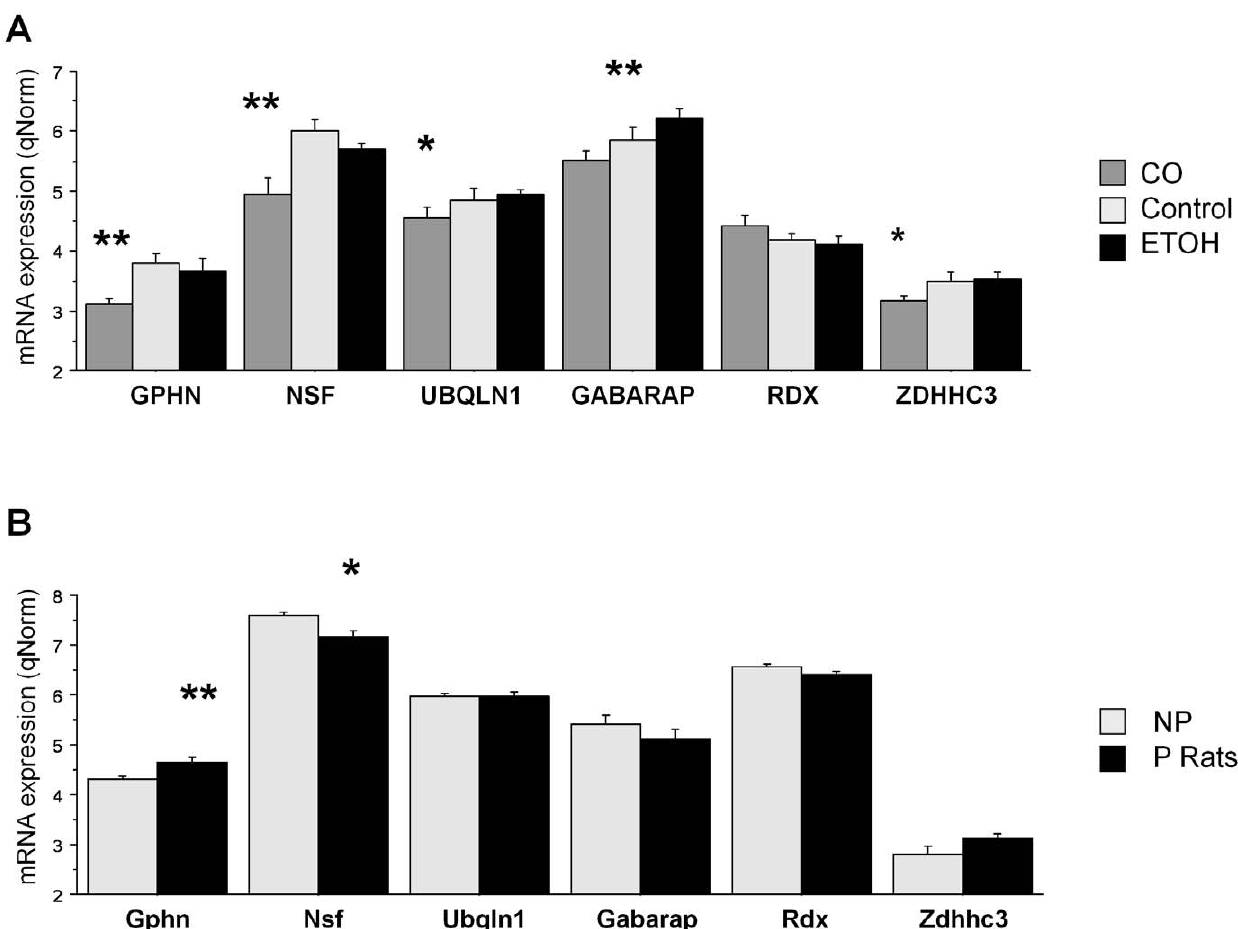
Figure 3. The Expression of Genes Encoding GABAA Receptor Associated Proteins in Human Samples and Rat Samples. ETOH=alcoholics; CO=cocaine addicts. Error bars: standard errors. ** FDR p , 0.05; * FDR p #